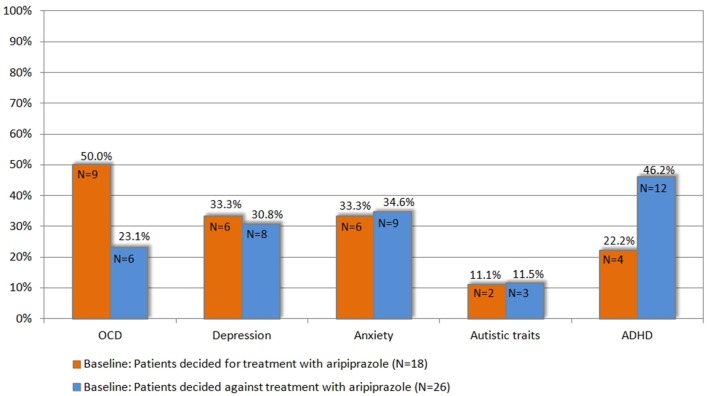
Prevalence of comorbidities at baseline in patients who decided for vs. those who decided against treatment with aripiprazole (for definition of psychiatric comorbidities (OCD, ADHD, depression, anxiety, and autistic traits) refer to chapter 2.3).